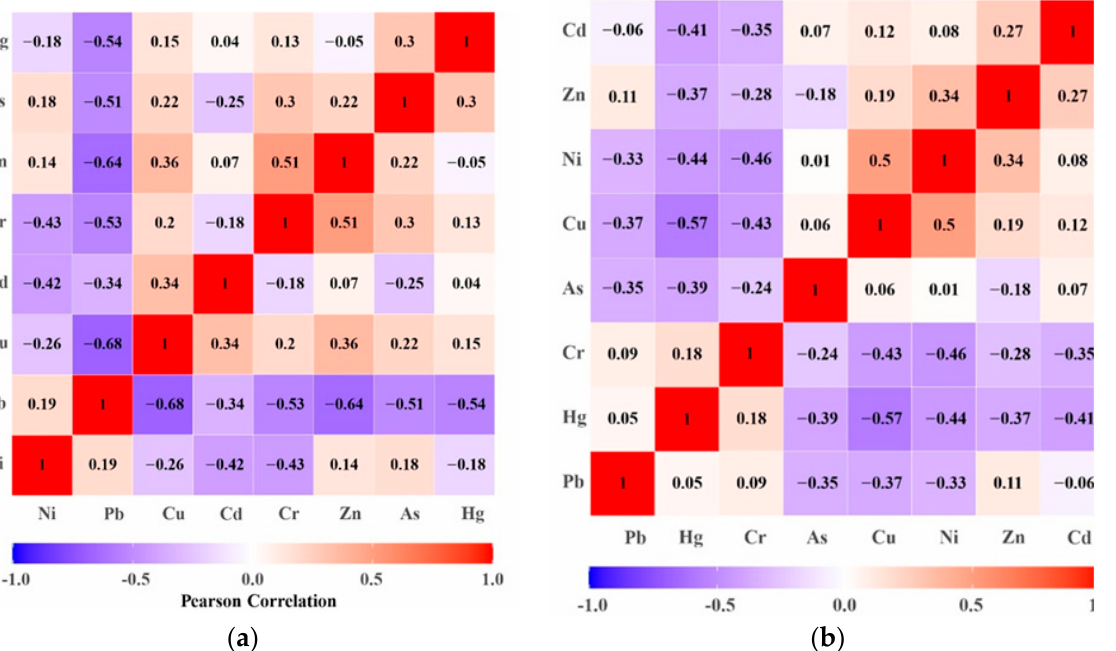
Figure 9. PC1 and PC2 biplot of the PCA in the surface sediments from Yueliang Lake. The variance contribution rate of the first principal component (F1) is 45.78%. The heavy metals with high load are Cr, Ni, Cu, Zn and As, which represent natural sources